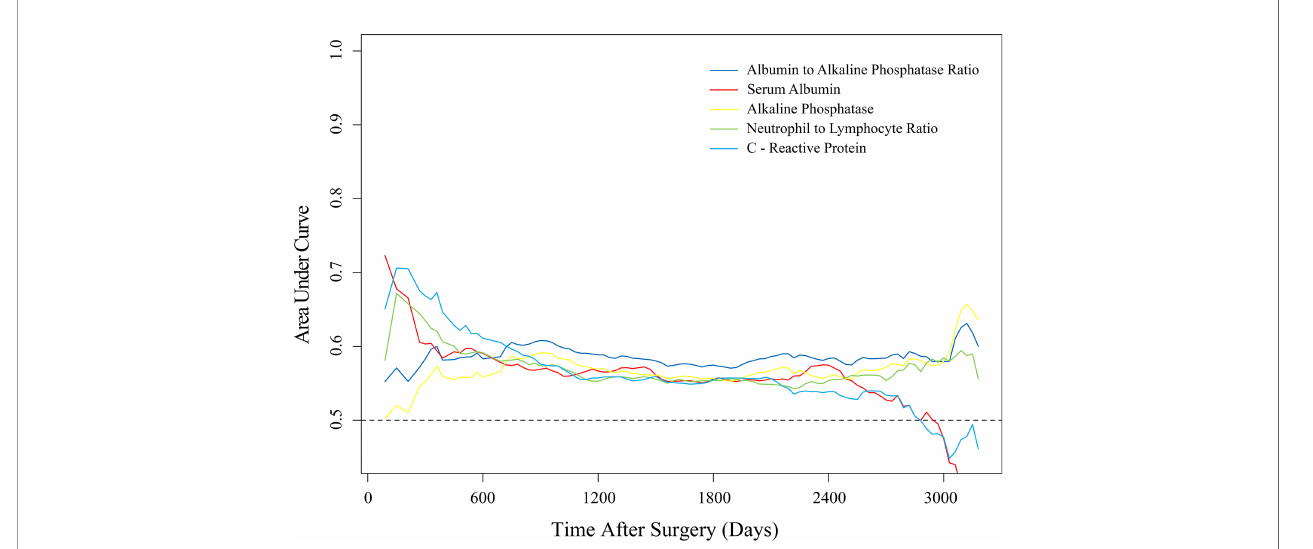
FIGURE 3 | Time-dependent ROC analysis of the discriminatory ability of laboratory-assayed biomarkers for postoperative survival during